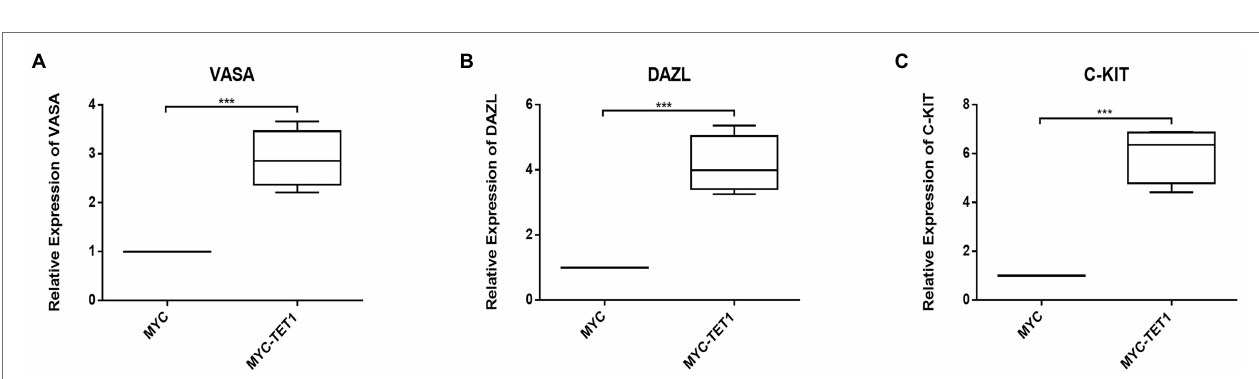
FIGURE 3 | Relative expression of specific genes in spermatogonial cells. (A) The mRNA expression of VASA in spermatogonial cells was detected by QRT-PCR. (B) The mRNA expression of DAZL in spermatogonial cells was detected by QRT-PCR. (C) The mRNA expression of C-KIT in spermatogonial cells was detected by QRT-PCR. p < .001(***), p < .01(**), p <